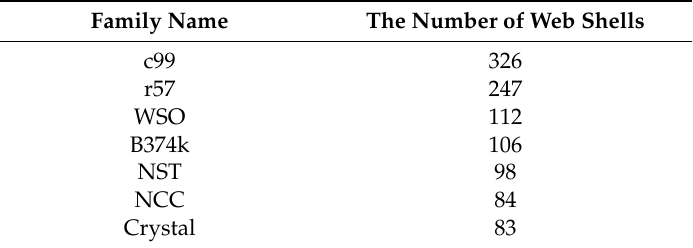
Table 1. The final clustering results of 1056 web shells, which are based on a clustering threshold of